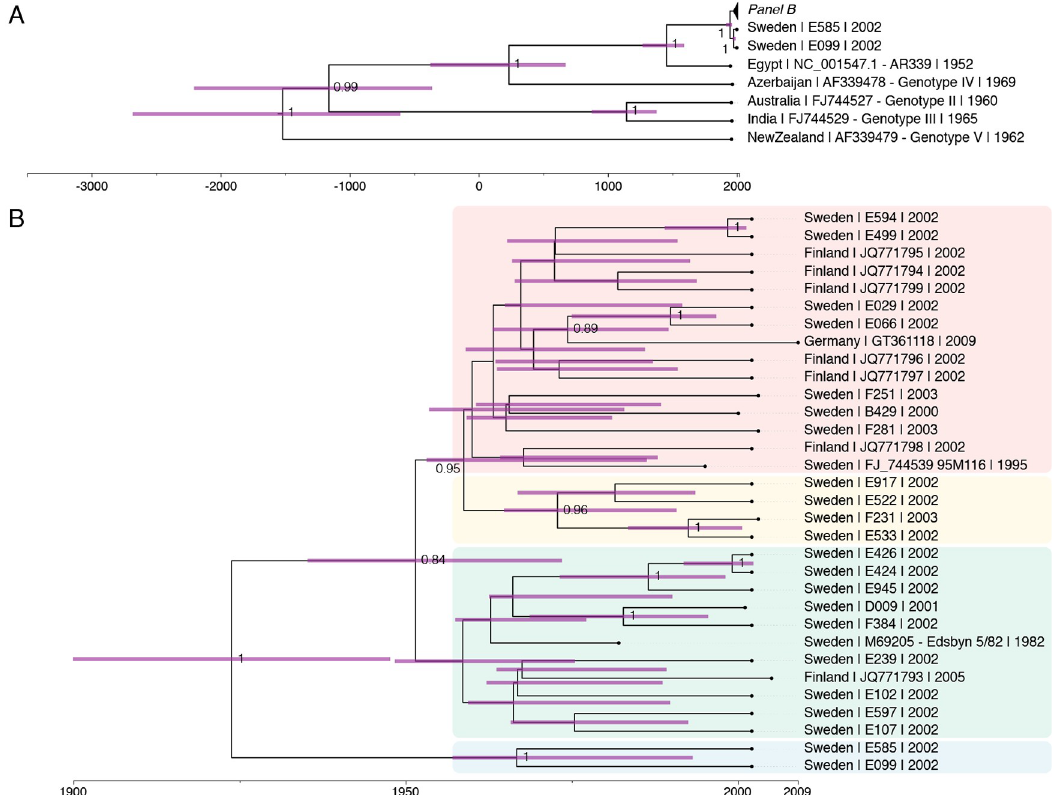
Fig 6. Maximum clade creditability tree obtained from four independent Markow Chain Monte Carlo runs of 22 partial Sindbis virus sequences of strains from Sweden, Finland, Germany, Egypt, Azerbaijan, Australia, India and New Zealand: A) the major branching of five Sindbis genotypes with all Swedish strains in genotype I (SINV-I), and with a time line showing that the most basic branching occurred approximately 2000 years ago. B) Detail of panel B showing the branching patterns among SINV-I strains from Sweden, Finland and Germany, and with a timeline showing that the most basic branching occurred already in the first half of the previous century. The black lines show the branching pattern and the horizontal purple lines show standard deviations of time estimates for each